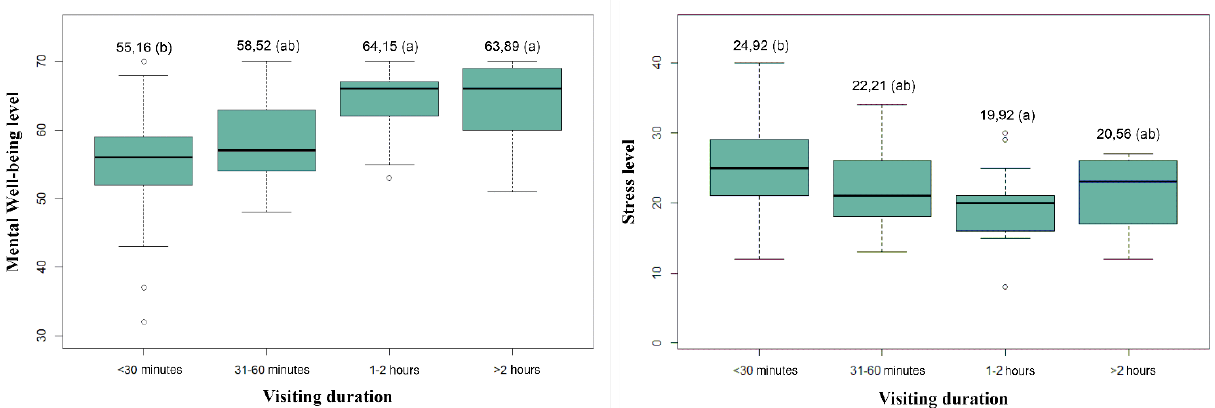
Figure 9 . Box plot with the average factor of spending time duration in the garden in each visit related to the level of mental well-being (left) and level of stress